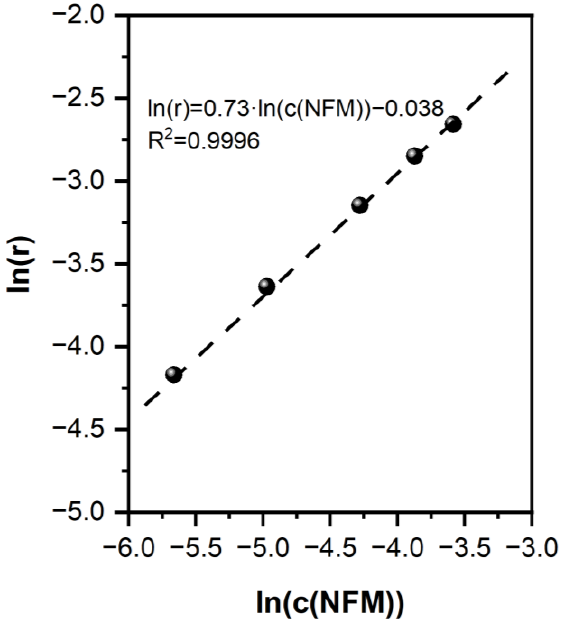
Figure 6. Linear plot of ln ( r ) versus ln ( c ( NFM )) resulting from the alcoholysis reaction of NFM. Reaction conditions: 0.3 g 13.5% CaO/MgO, NFM, 120 °C, 15 mL methanol.